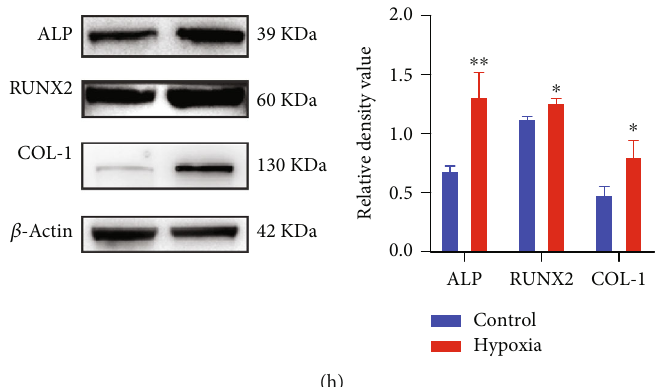
Figure 1: Hypoxia promoted proliferation, migration, and osteogenic di ff erentiation in hPDLCs. Cells separated from periodontal ligaments were characterized by fl ow cytometry, showing positive expression of markers of MSCs (a). hPDLCs cultured in the normoxia and hypoxia were visualized using a microscope at 24h (b). Proliferation of hPDLCs was evaluated by the CCK8 assay at 24h (c). Transcription of cell cycle-related genes was determined by qPCR at 4 h (d). Scratch-healing model was utilized to determine hPDLC migration capacity at 24h, and the healed/wounded area ratio was calculated ( n = 3 ) (e). ALP staining was conducted on cells cultured in the osteogenic medium after 7 days (f). The mRNA of osteogenesis-related genes at 24 h was analyzed by qPCR ( n = 3 ) (g). Protein expression of ALP, RUNX2, and Col-1 at 72h was assayed by western blot; the blots were representative of three independent experiments (h). ∗ p < 0 : 05 , relative to control; ∗∗ p < 0 : 01 , relative to